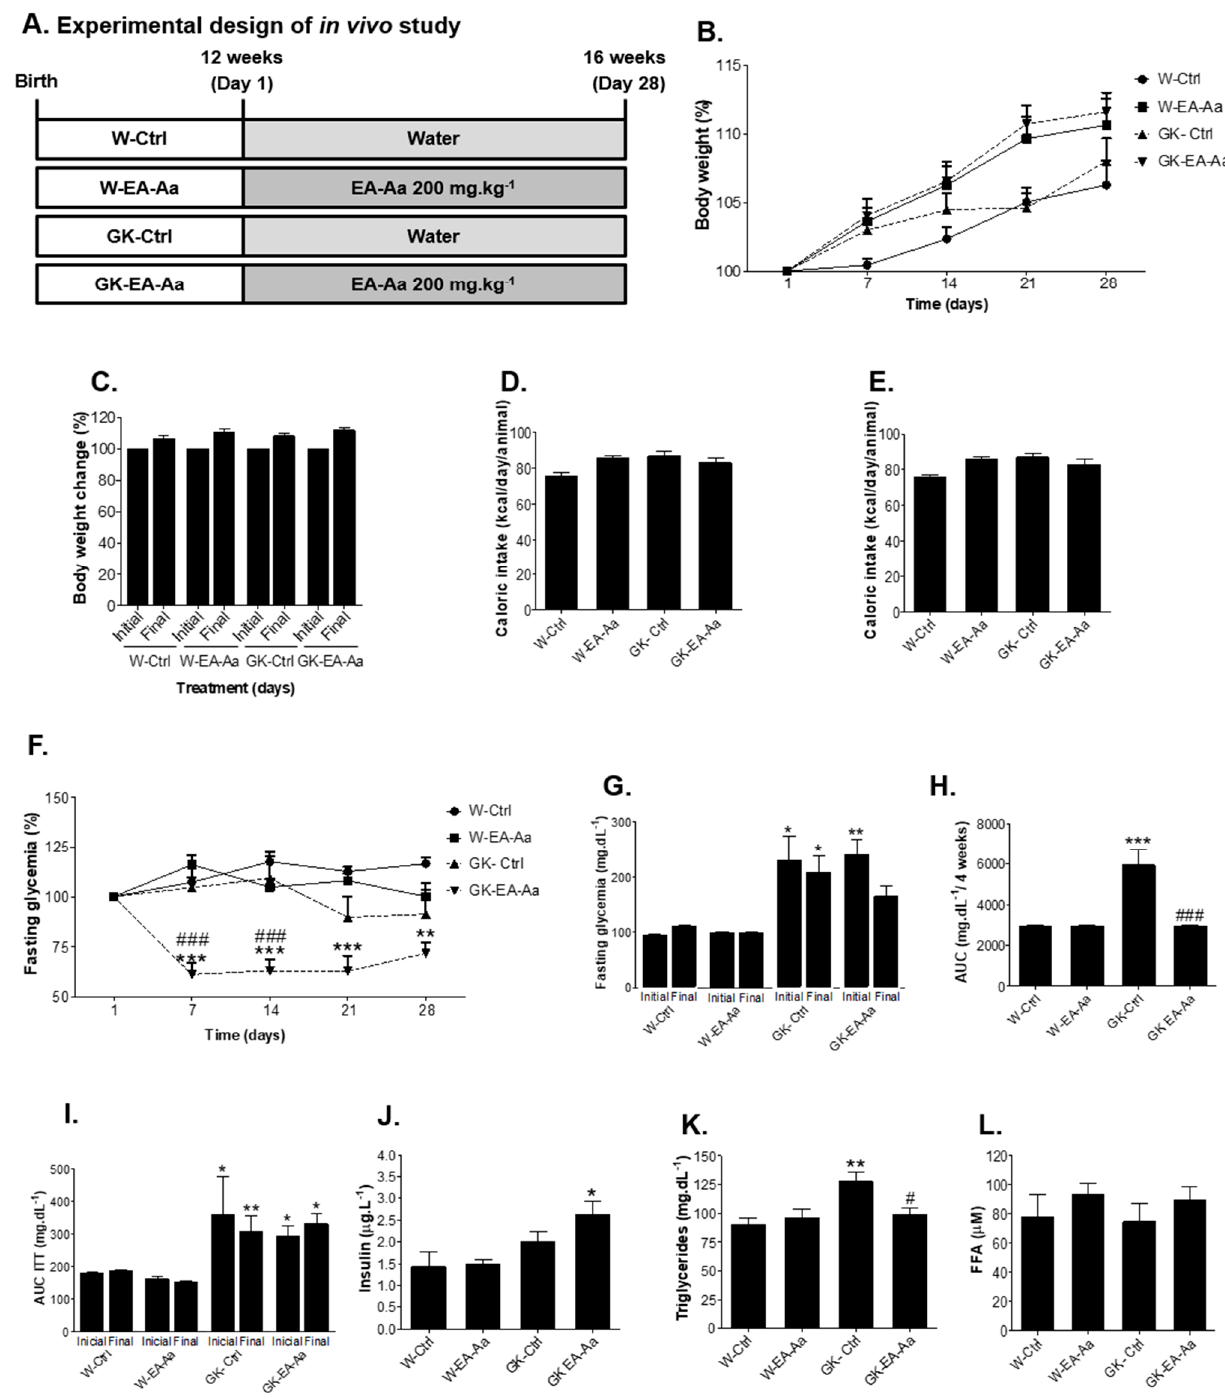
Figure 1. Glycaemic and lipid profile of Wistar and Goto–Kakizaki (GK) rats after 30-day treatment ( n = 5–7). ( A ) Experimental design of in vivo study. ( B ) Body mass evolution of treated and non-treated rats represented every 7 days. ( C ) Initial and final body mass of treated animals. ( D ) Caloric intake. ( E ) Fasting blood glucose in percentage of the initial value; EA-Aa promoted a decrease in fasting glycaemia of GK-EA-Aa since the 7th day of treatment in relation to the initial glycaemia. ( F ) Fasting glycaemia; a restoration of values is found in the end of the treatment between GK rats and W-Ctrl group. ( G ) Area under the curve of glycaemia along 4-week treatment period; values are reduced by EA-Aa treatment in GK rats when comparing to the control group. ( H ) Area Under the curve of the glycaemia along all the treatment. ( I ) Area under the curve of ITT (insulin tolerance test). ( J ) Insulin; an increase in GK-EA-Aa is presented in relation to the W-Ctrl group. ( K ) Triglycerides; treatment with EA-Aa decreased plasma triglycerides levels in GK. ( L ) Free fatty acid levels. * vs. W-Ctrl at the same point; # vs. GK-Ctrl at the same point; *,# p < 0.05; ** p < 0.01; ***,### p < 0.001.